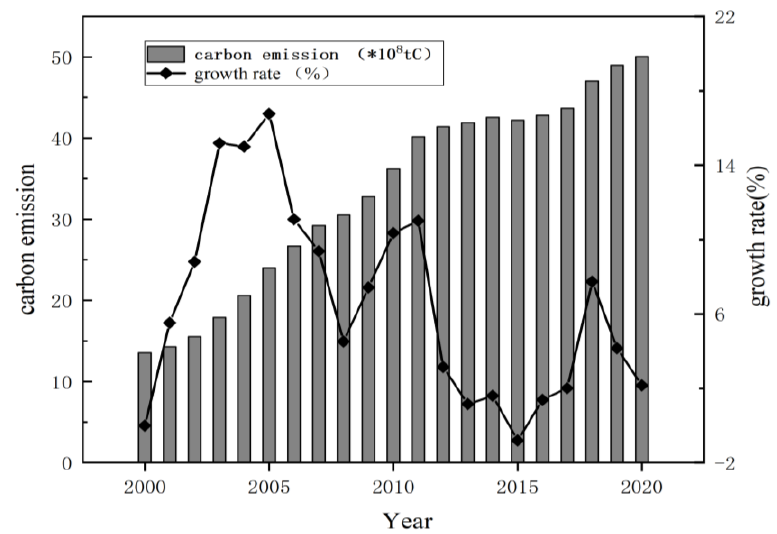
Figure 1. Total carbon emissions and annual growth rate in China from 2000 to 2020.